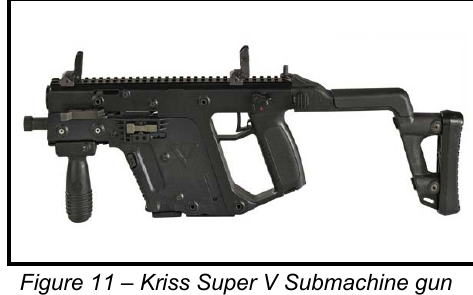
Figure 11 – Kriss Super V Submachine gun Рис . 11 – Автомат Kriss Super V Слика 11 – Аутомат Kriss Super